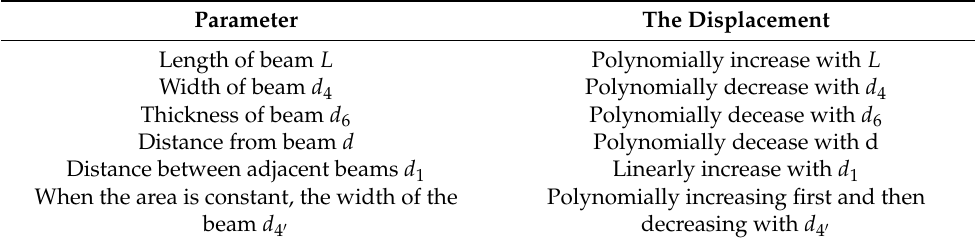
Table 5. Summary of the 3D U-shaped actuator parameter analysis.